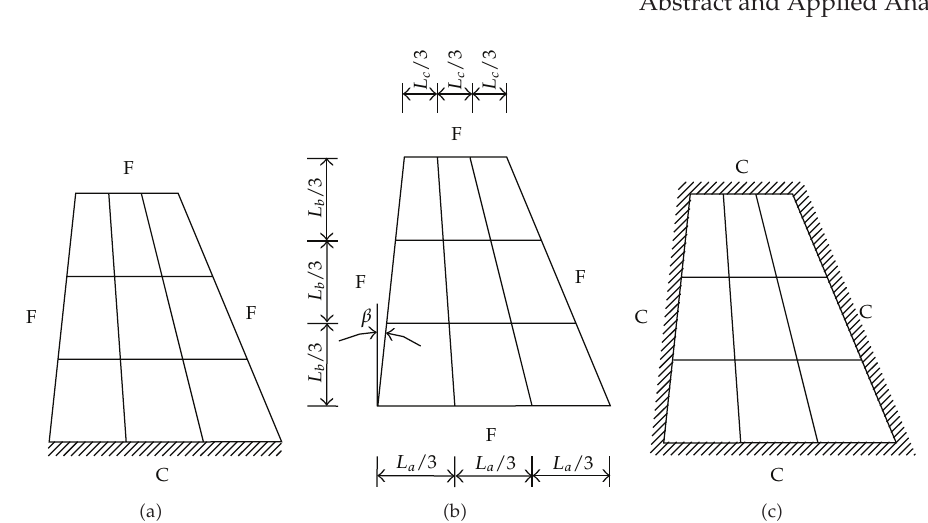
Figure 5: The 3 meshes adopted for the 10mm aluminum trapezoidal plates with 1mm PZT-5H layers perfectly bonded on both the upper and lower surfaces having various boundary conditions (cid:3) the number of Fourier terms: p (cid:8) q (cid:8) 5, L a (cid:8) 0 . 1m (cid:6)